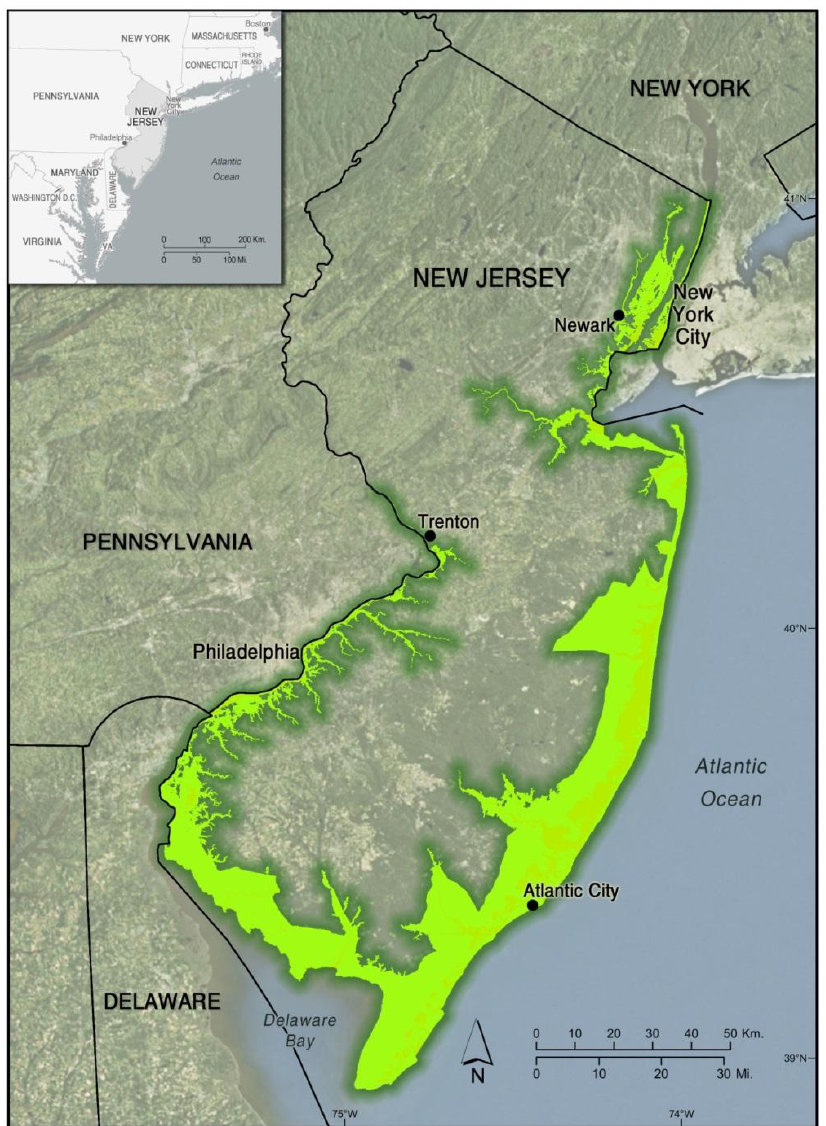
Figure 2. NJFloodMapper study area; the designated coastal zone shown is in shades of green. Imagery backdrop courtesy of ESRI web